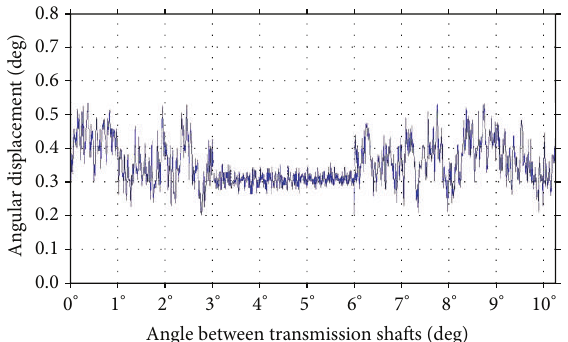
stabilize fluctuation is largest. While angle is 5 ∘ ∼6 ∘ , driving gear can quickly enter smooth transmission and fluctuation of angular velocity is minimal.